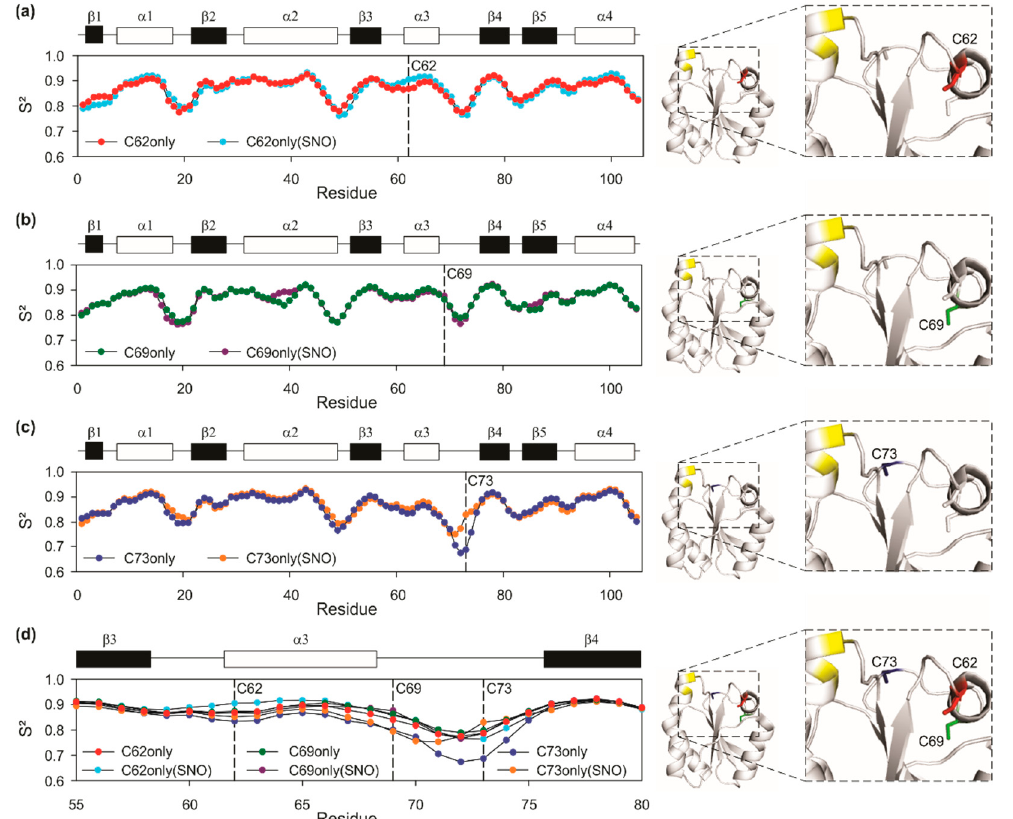
Figure 5. Random Coil Index for chemical shifts of the backbone. Each point on the graph represents a value for the order parameter (S 2 ) calculated for each residue based on the C α , CO, C β , N, H α , and NH chemical shifts, the lower the S 2 the greater the flexibility. On the right side, hTrx structures (PDB 4TRX). C62, C69, and C73 are colored in red, green, and blue, respectively. C32 and C35 are colored in yellow. ( a ) Red dots belong to the C62only mutant, and the cyan dots belong to the C62onlySNO mutant. From the S-nitrosation of residue C62, the region comprising residue S73 became more flexible, given a decrease in S 2 . The α 3 helix, on the other hand, showed greater rigidity when residue C62 was S-nitrosated. ( b ) Green and magenta dots represent C69only and C69onlySNO residues, respectively. C69 S-nitrosation resulted in a small increase in flexibility of α 3 and α 3/ β 4 loop. ( c ) Blue and orange dots represent C73only and C73onlySNO residues, respectively. Note that C73 S-nitrosation resulted in a remarkable rigidity increase at α 3/ β 4 loop, which characterizes an entropically unfavorable process. ( d ) Residues from the nitrosative site region with all mutants S 2 plots combined.